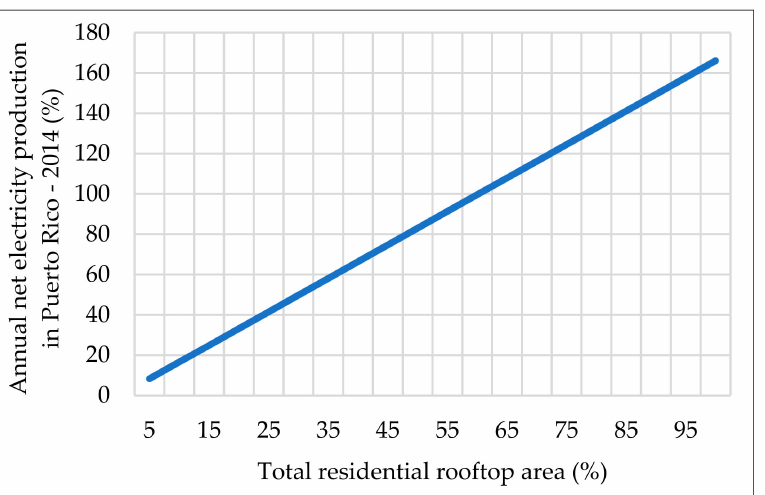
Figure 12. Annual electricity production by PV systems installed on residential rooftop surface (based on the Puerto Rico annual net electric energy production in